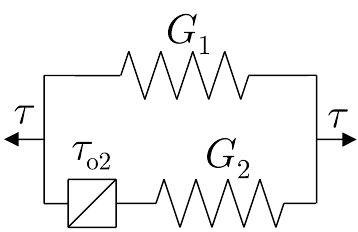
Figure 5. The scheme of elastic–plastic model with kinematic hardening.